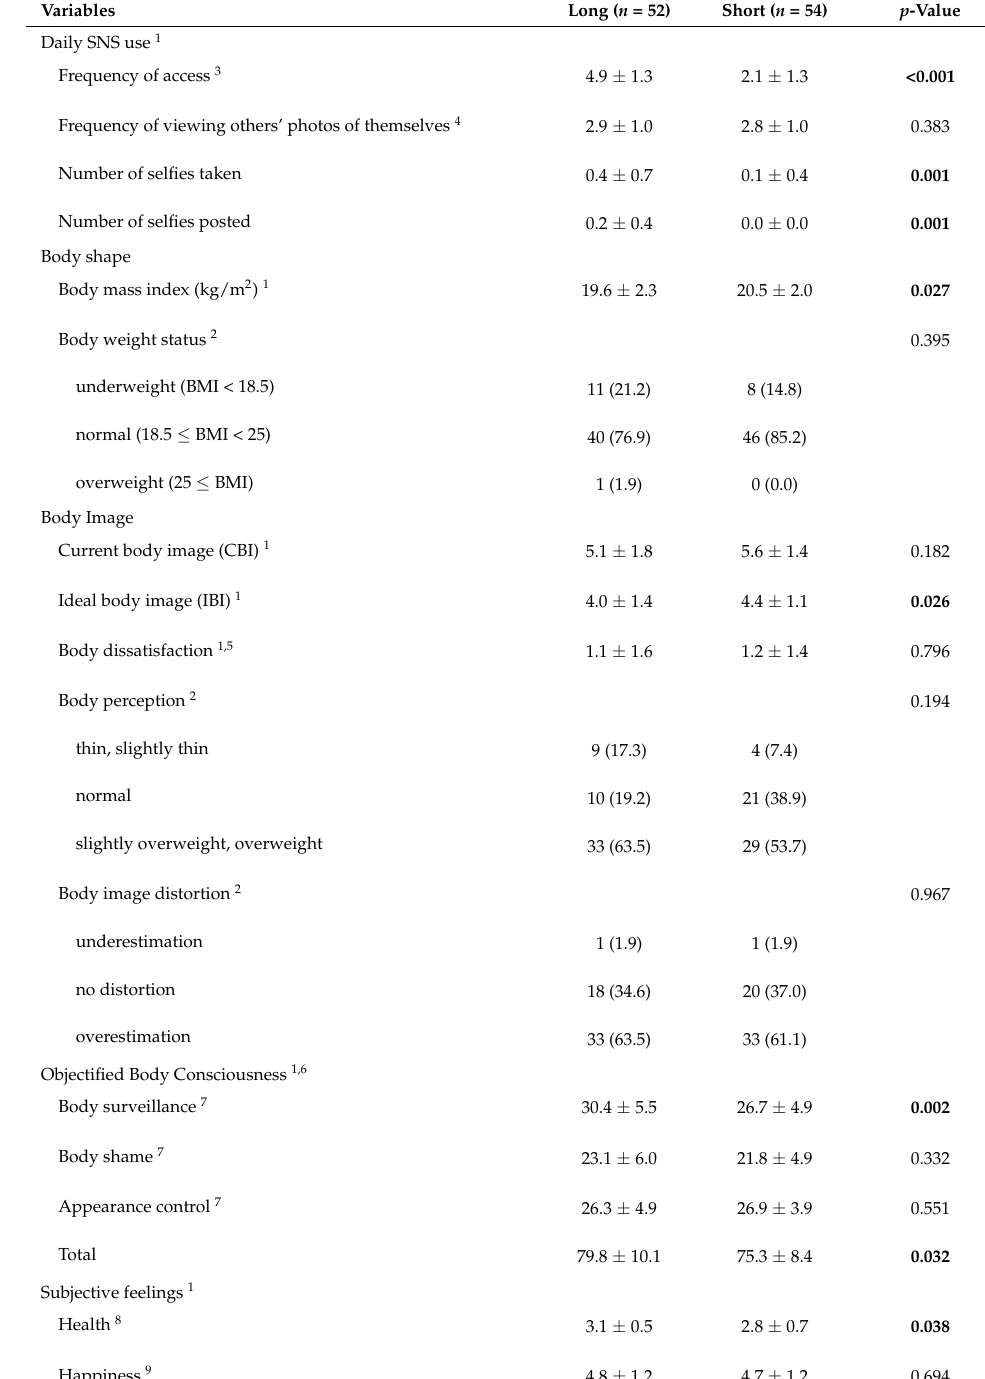
Table 1. Daily SNS use, body shape, body image, objectified body consciousness, and subjective feelings by the duration of SNS